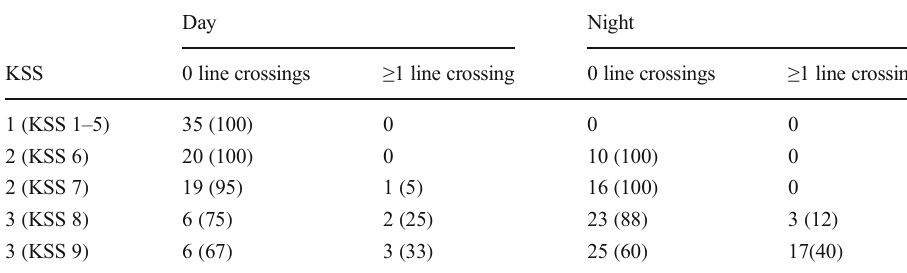
Table 3 The number of line crossings during day and night- time at different KSS levels. Percentages of observations dis- tributed per KSS, separated for day/night, in